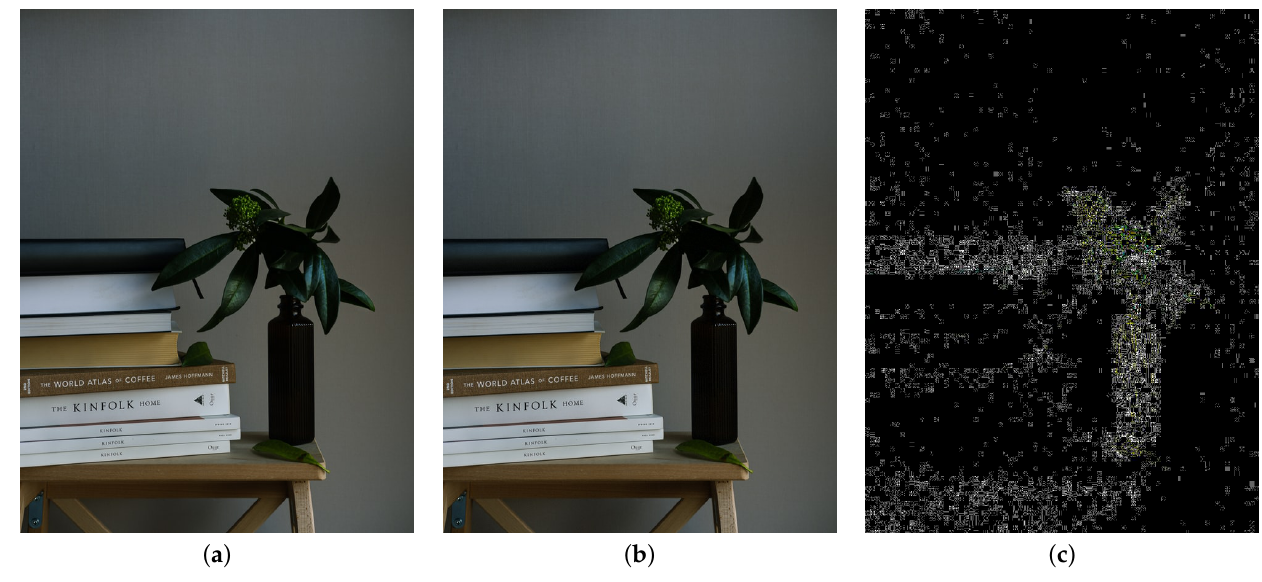
Figure 1. ( a ) Clean image, ( b ) image with data hidden using UERD algorithm, and ( c ) differential image between them, scaled 100 times. Density of steganographic data: 0.4 bpnzac, which means here 2638 B of hidden data in each 53 kB image file. Clean image source: unsplash.com (accessed on 8 April